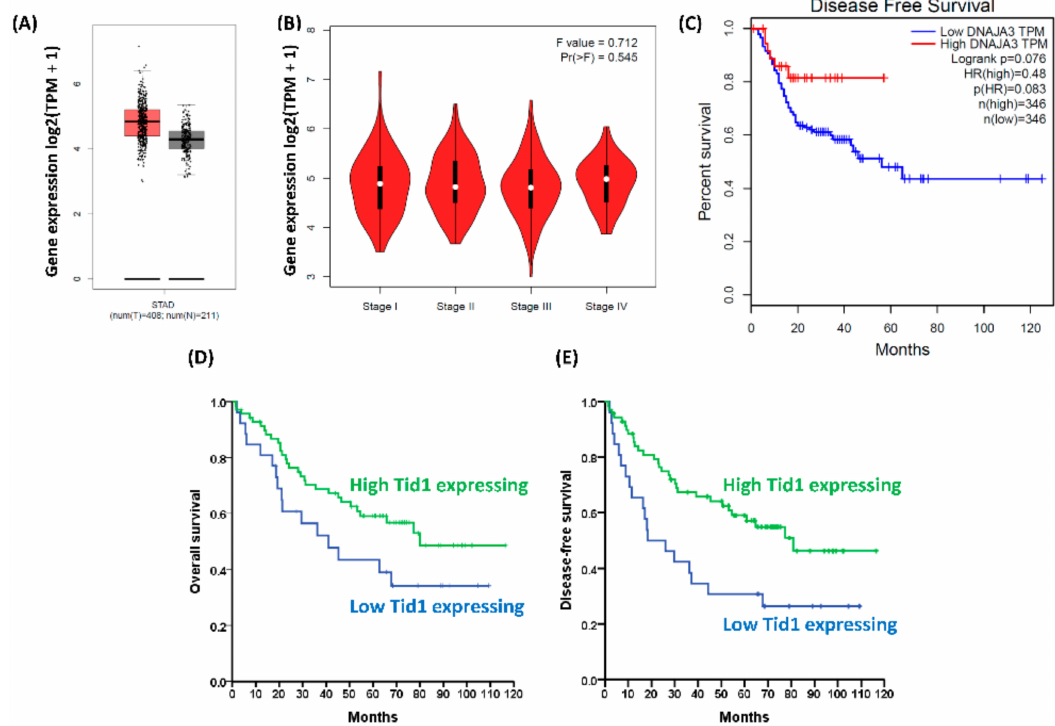
Figure 1. The expression of Tid1 and its clinical e ff ects in gastric cancers. ( A – C ) Using the TCGA database and the GTEx project, the boxplot, stage plot, and Kaplan–Meier plot were analyzed using the GEPIA online database and software (http: // gepia.cancer-pku.cn / ). ( A ) The gene expression of Tid1 in normal tissues (gray box) and tumor tissues (red box) was analyzed by box-plot. STAD: stomach adenocarcinoma, T (tumor) number: 408, N (normal) number: 211; | Log 2 FC | cuto ff : 1; p -value cuto ff : 0.01. ( B ) The association between gastric cancer stages and Tid1 gene expression was analyzed by stage-plot. F value = 0.712; Pr ( > F) = 0.545. ( C ) The Kaplan–Meier survival analysis for Tid1 expression and DFS in gastric cancer patients. Log-rank p = 0.076. ( D , E ) Using immunohistochemical (IHC) staining for Tid1 protein expression in gastric cancer samples, we compared survival between gastric cancer patients with high and low Tid1 protein expression. ( D ) Gastric cancer patients with high Tid1 expression had a trend of better OS rates than those with low Tid1 expression, p = 0.082 (log rank test). ( E ) Gastric cancer patients with high Tid1 expression had a better DFS rate than those with low Tid1 expression, p = 0.008 (log rank